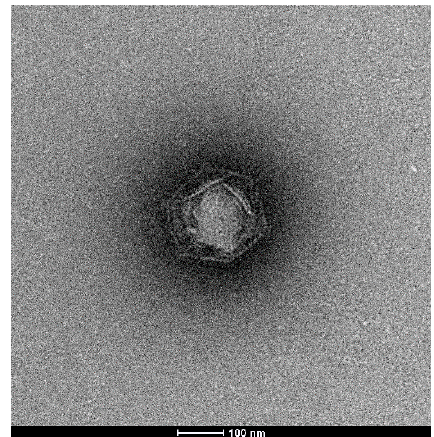
Figure 1. Electronic microscopy observation of negatively stained Kaumoebavirus LCC10.